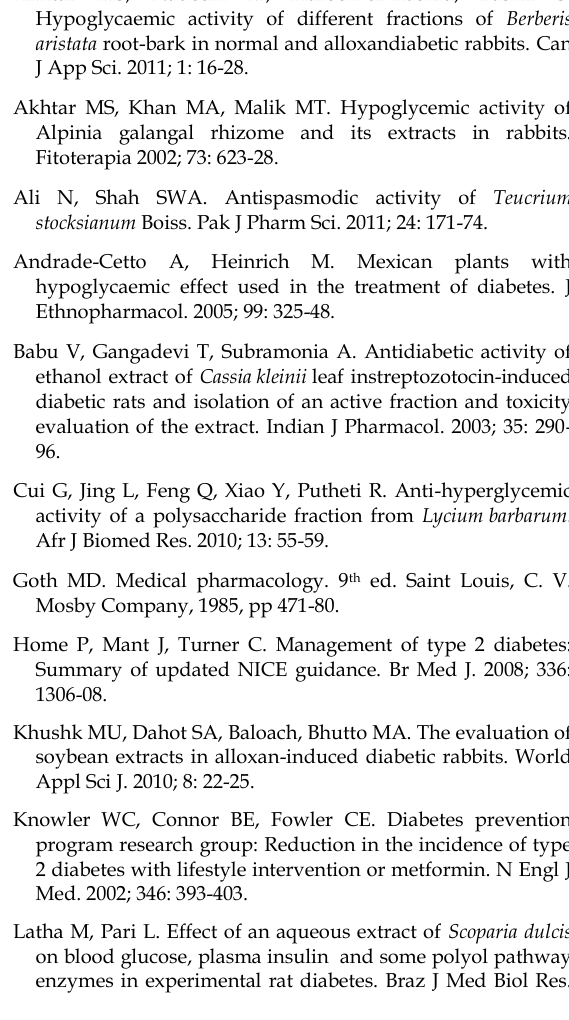
Figure 7: Effect of ethyl acetate extract of Teucrium stocksianum on hemoglobin (Hb) and glycosylated hemoglobin (HbA1c) levels in diabetic rabbits. (n = 6) where, ns = Non-significant change, a significant increase (p<0.001) b Significant decrease (p<0.001) com- pared to diabetic control as compared to diabetic control